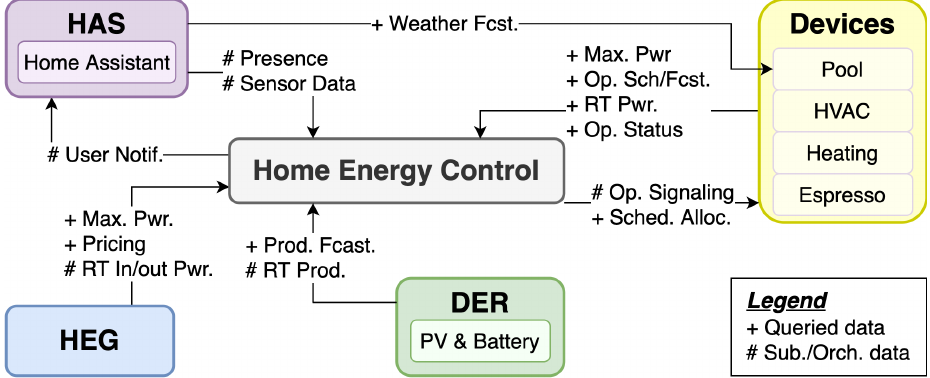
Figure 16. Test-bed Energy Management Components and